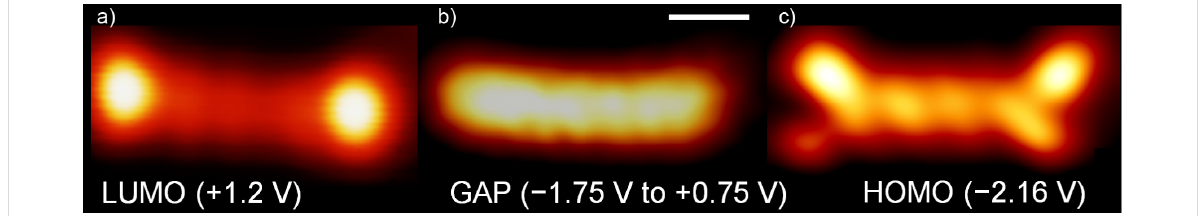
Figure 3: Spatial mapping of the molecular orbitals of pentacene. a) At positive bias voltages (LUMO), b) inside the gap and c) at negative (HOMO) bias voltages (bias voltages are indicated in the image). The scale bar equals 0.5 nm (the voltage is indicated in the images, I = 50 pA, constant height).